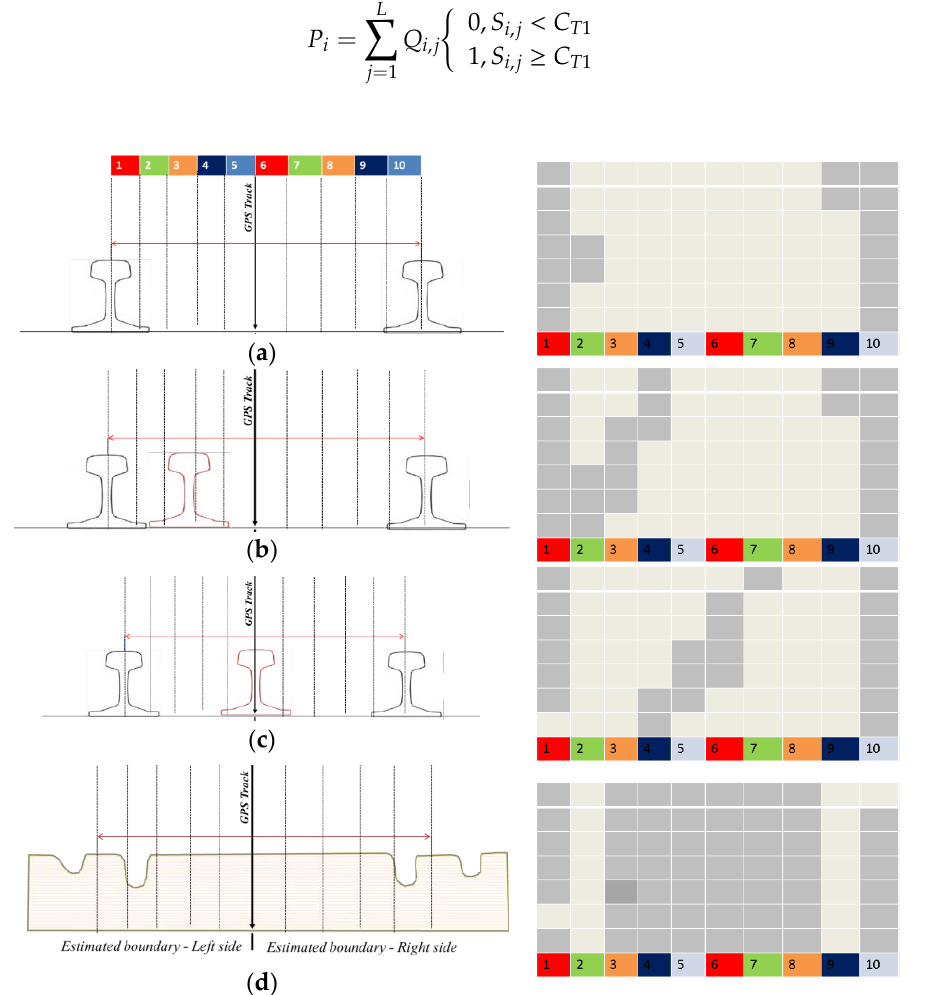
Figure 7. Proposed vertical slice for point density extraction near to the railway: ( a ) ideal track ( b ) beginning of the track turnout ( c ) passing of the track turnout ( d ) the level crossing. L is the maximum number of iterations in the cross-track direction. If j moves until 1 to L, then the crossings can be identified by exceeding the value of C T 1 as depicted in Figure